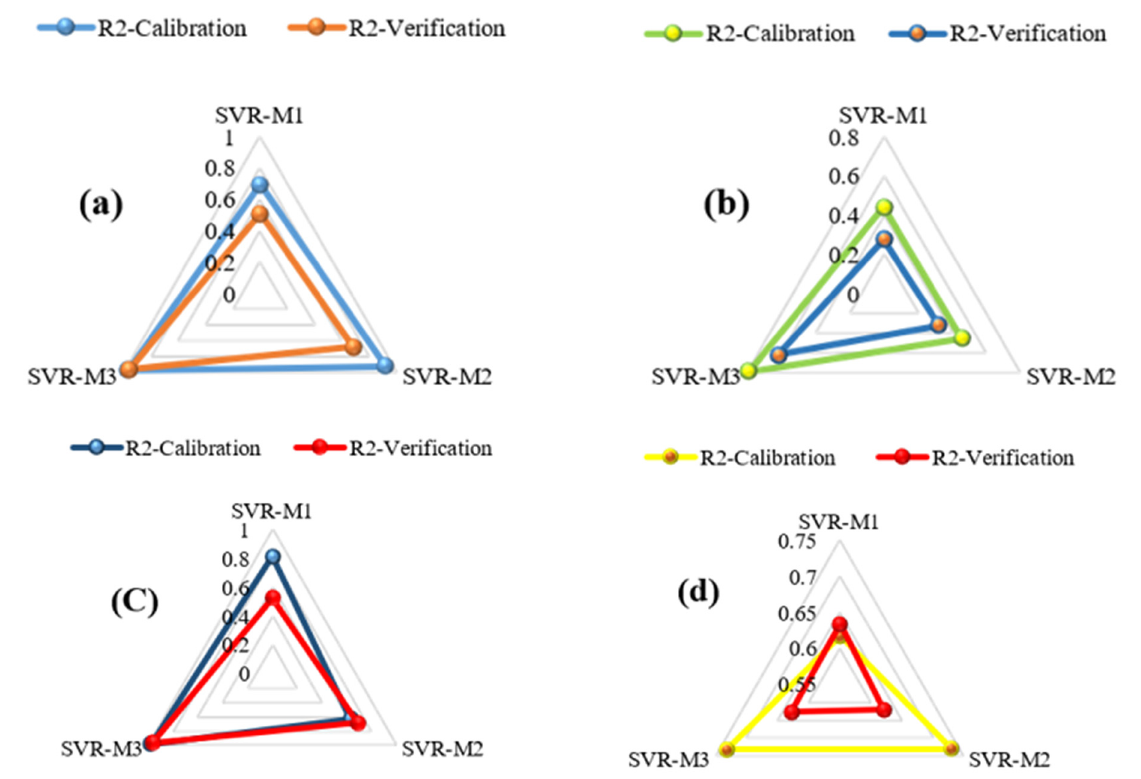
Figure 8. Radar graph for ( a ) Kano, ( b ) Abuja, ( c ) Niger, and ( d ) Lagos in both calibration and verification phases. However, the overall accuracy of Abuja was unsatisfactory and recorded high uncer- tainty with regard to errors regardless of considering the non-linear relationship between predictors and their corresponding targets. This could be improved by introducing opti- mization algorithms (PSO and HHO). Basically, it should be taken into consideration that the promising estimations took place during the calibration phase which is primarily em- ployed to effectively calibrate the models based on known input variables and targets. However, the testing step is vital in assessing the performance of a model since it examines the model’s accuracy based on unseen target values. This benefit does not exist in the training set. Therefore, a reliable model should have a stable and balanced performance in both calibration and verification phases. The section of optimization algorithms gener- ally depicted a promising ability with regard to the single model. This is not surprising, as it can be seen in many studies [51–55]. As with the single model, the simulation perfor- mance of the metaheuristic algorithms was evaluated using R 2 , MSE, RMSE, R, and MAPE for consistency. Table 2 presents the results of SVR-PSO and SVR-HHO for both training and verification phases. From Table 2, SVR-HHO has the highest R 2 values of 0.9951, 0.8963, 0.9951, and 0.9313, the lowest MSE values of 0.0002, 0.0070, 0.0002, and 0.0080, and the lowest MAPE values of 0.1311, 0.1452, 0.0599, and 0.1817, respectively, for Kano, Abuja, Niger, and Lagos. The results prove that SVR-HHO outperformed SVR-PSO for the simulation of load demand at Kano, Abuja, Niger, and Lagos. The predictive ability of HHO over others is consistent with findings from the works of [29,31,56]. The explora- tory analysis for the SVR-PSO and SVR-HHO models can also be better understood through the boxplots in Figure 9. As indicated in Figure 9, the computed models that mimic the pattern of the observed values are selected as the best performing model based on the box and whisker evolution criteria. The degree and trend patterns between the measured and computed models show that SVR-HHO > SVR-PSO > SVR-M3 ranked as the best model among all the models considered. Table 2. Results of SVR-PSO and SVR-HHO for Kano, Abuja, Niger, and Lagos. Calibration Phase